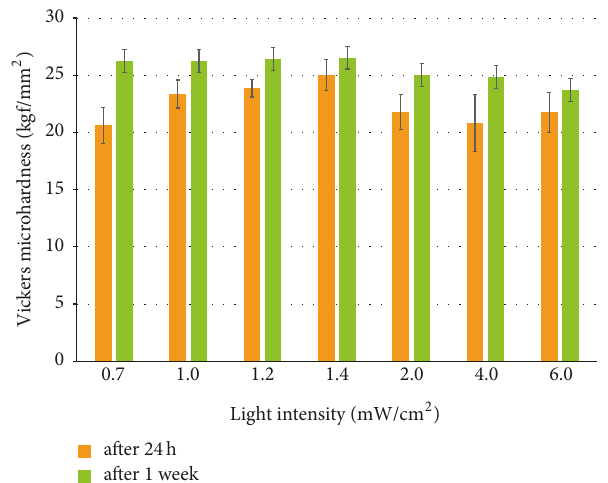
Figure 8: Vickers microhardness values for the samples cured by a LED light source at different intensities, with an irradiation time of 30 seconds, after storage for 24 hours and one